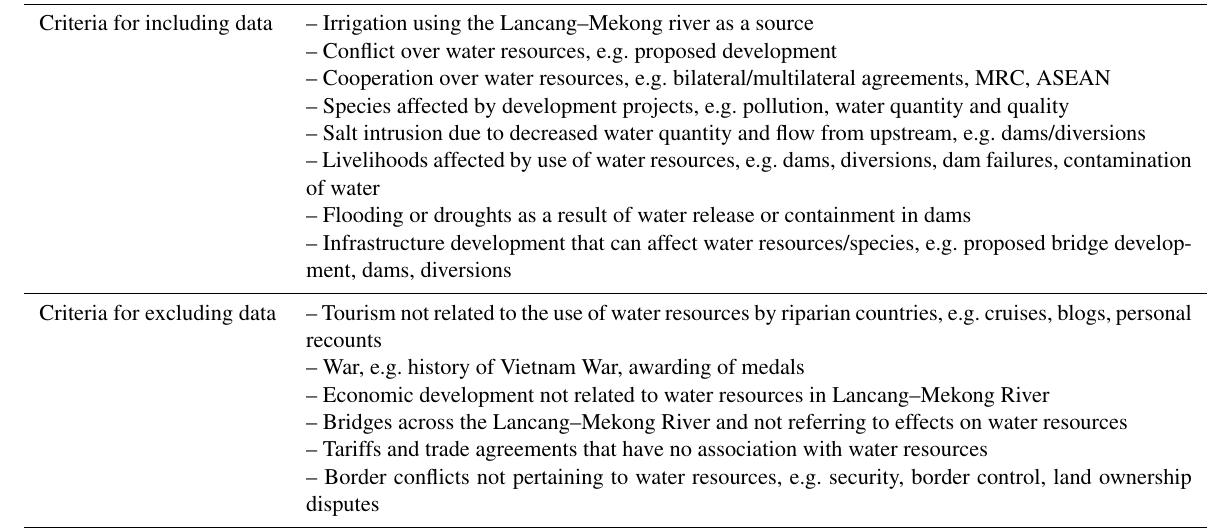
Table 2. Criteria for inclusion and exclusion of news articles. Criteria for including